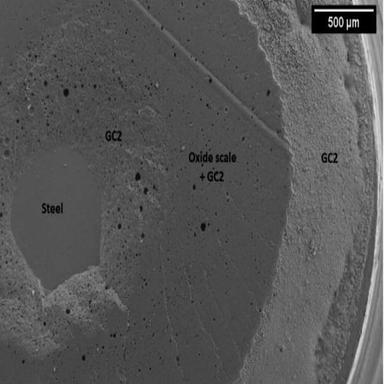
(a) anomalous fracture surfaces after torsion for some THG-5 GC2 joined sample tested at room temperature: (b) fracture propagation sketch (orange = glassceramic; grey = oxide scale; red = fracture propagation) with GC2 present mostly on one fracture surface, as observed by SEM-EDS in (c) with each region identified (For interpretation of the references to colour in this figure legend, the reader is referred to the web version of this article.).